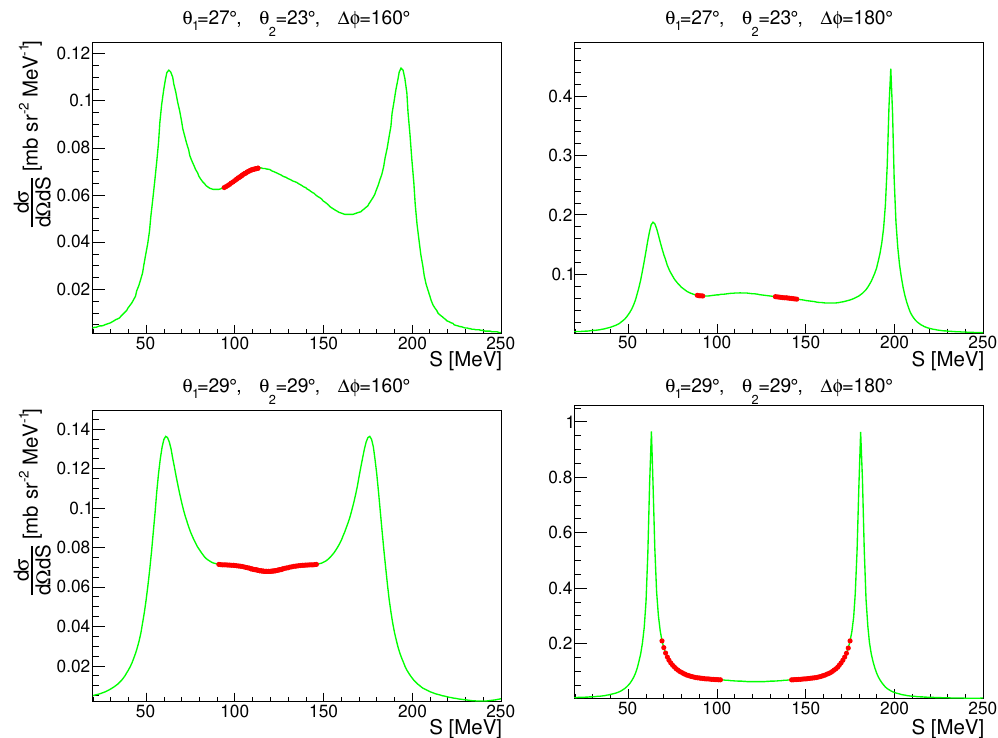
Figure 4: Examples of the differential cross sections of 1 H ( d , pp ) n breakup for two symmetric and two asymmetric angular configurations, specified in the figure. Green lines refers to the theoretical calculations based on the CD Bonn potential. Red solid lines and dots represent the regions useful for the cross-check